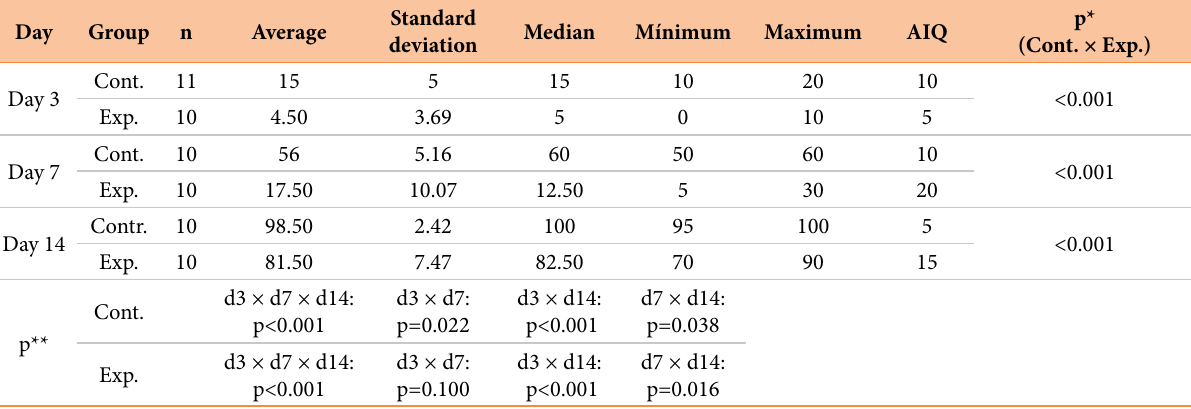
Table 4 - Average percentage of collagen I found in the three times, studied identified by immunohistochemistry.